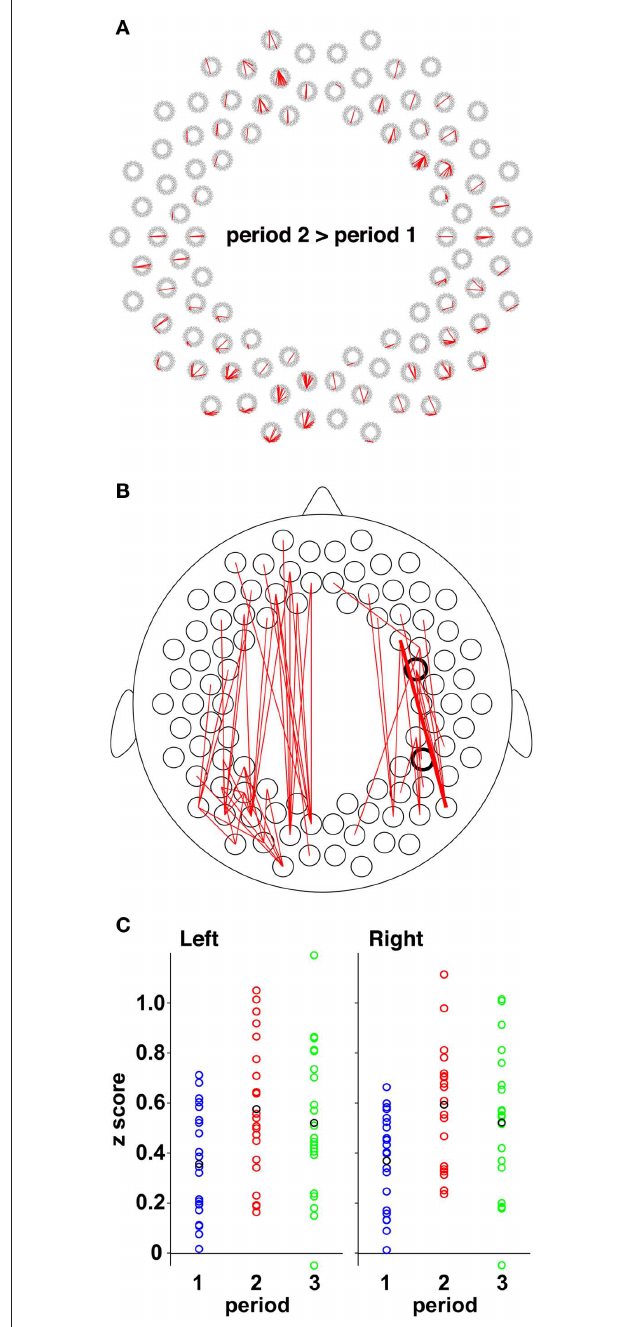
FIguRe 8 | The direct comparison between period 1 and period 2. (A) All the connectivity that showed higher correlations in period 2 in comparison with period 1 ( p < 0.005). (B) The ipsilateral connectivity revealed by the direct comparison ( p < 0.005). The bold line indicates the connectivity that showed the largest difference. The thick circles show the measurement channels of a right temporoparietal region and a right prefrontal region. (C) Individual data of temporal correlations normalized to z scores. The scatter plots show z scores in the pair indicated by the bold line in (B) and its left homologous pair. The blue, red, and green circles indicate individual data of z scores during periods 1, 2, and 3, respectively. The black circles indicate mean values in each